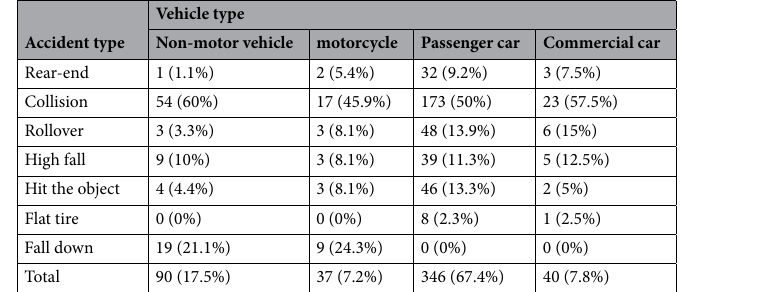
Table 4. Distribution of vehicle type in